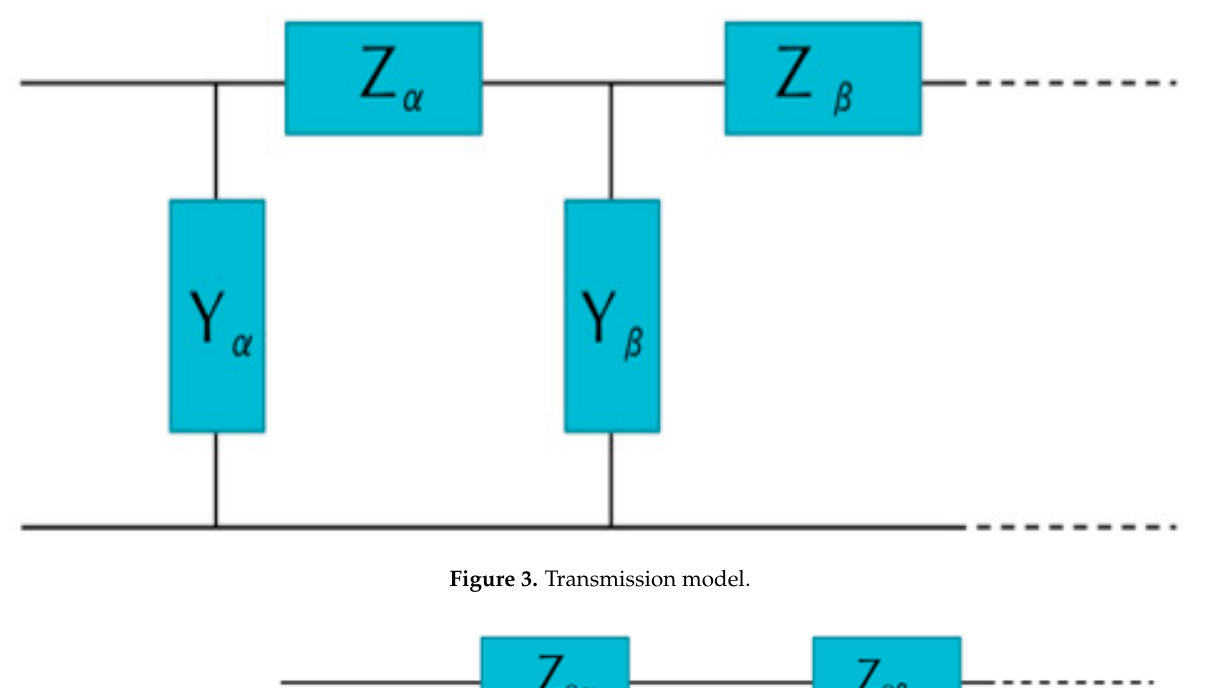
Figure 4. The equivalent transmission model used in the analysis.